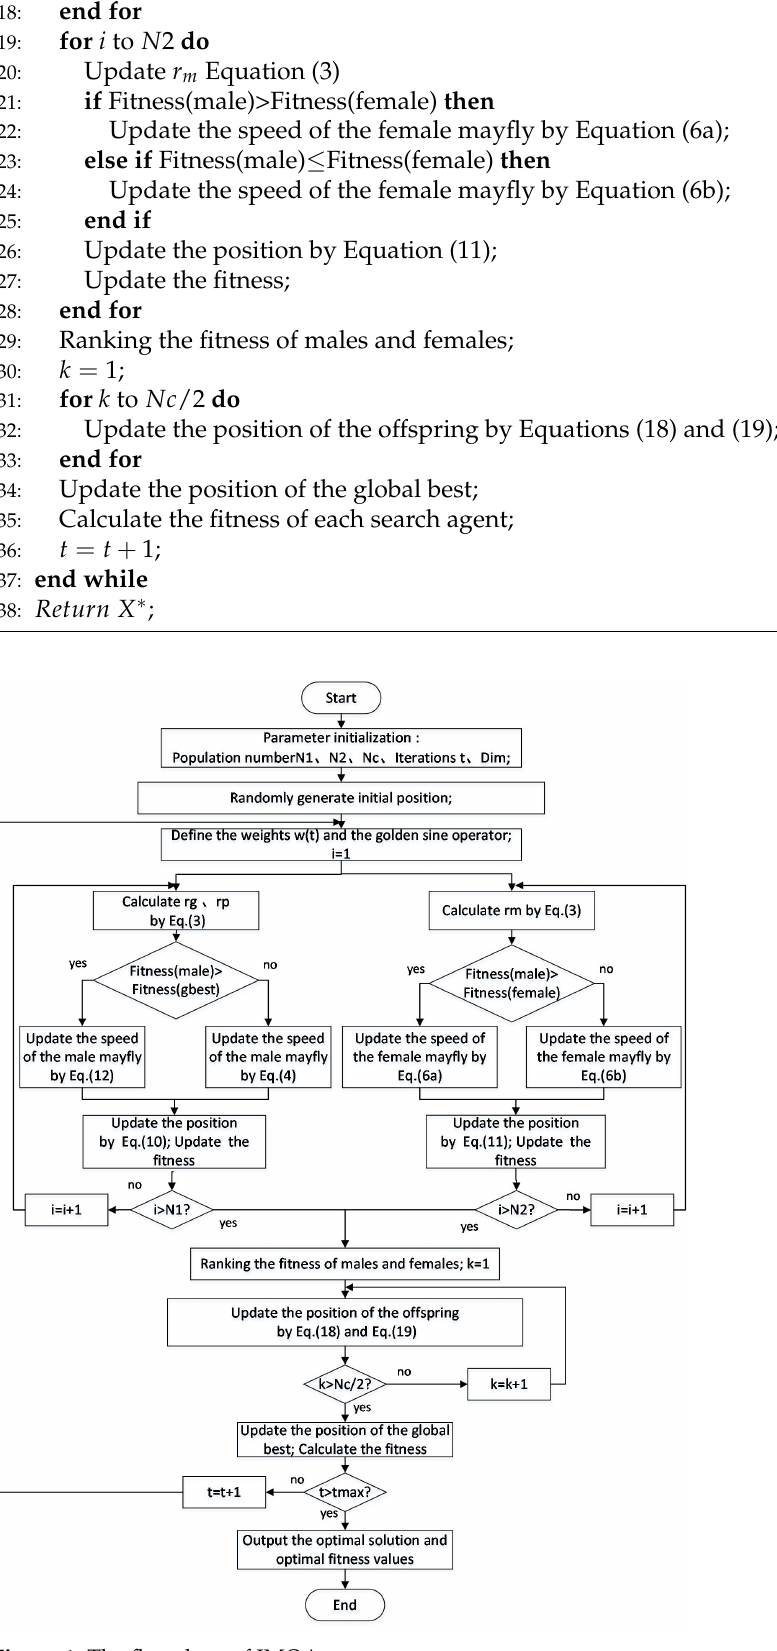
Figure 1. The flowchart of